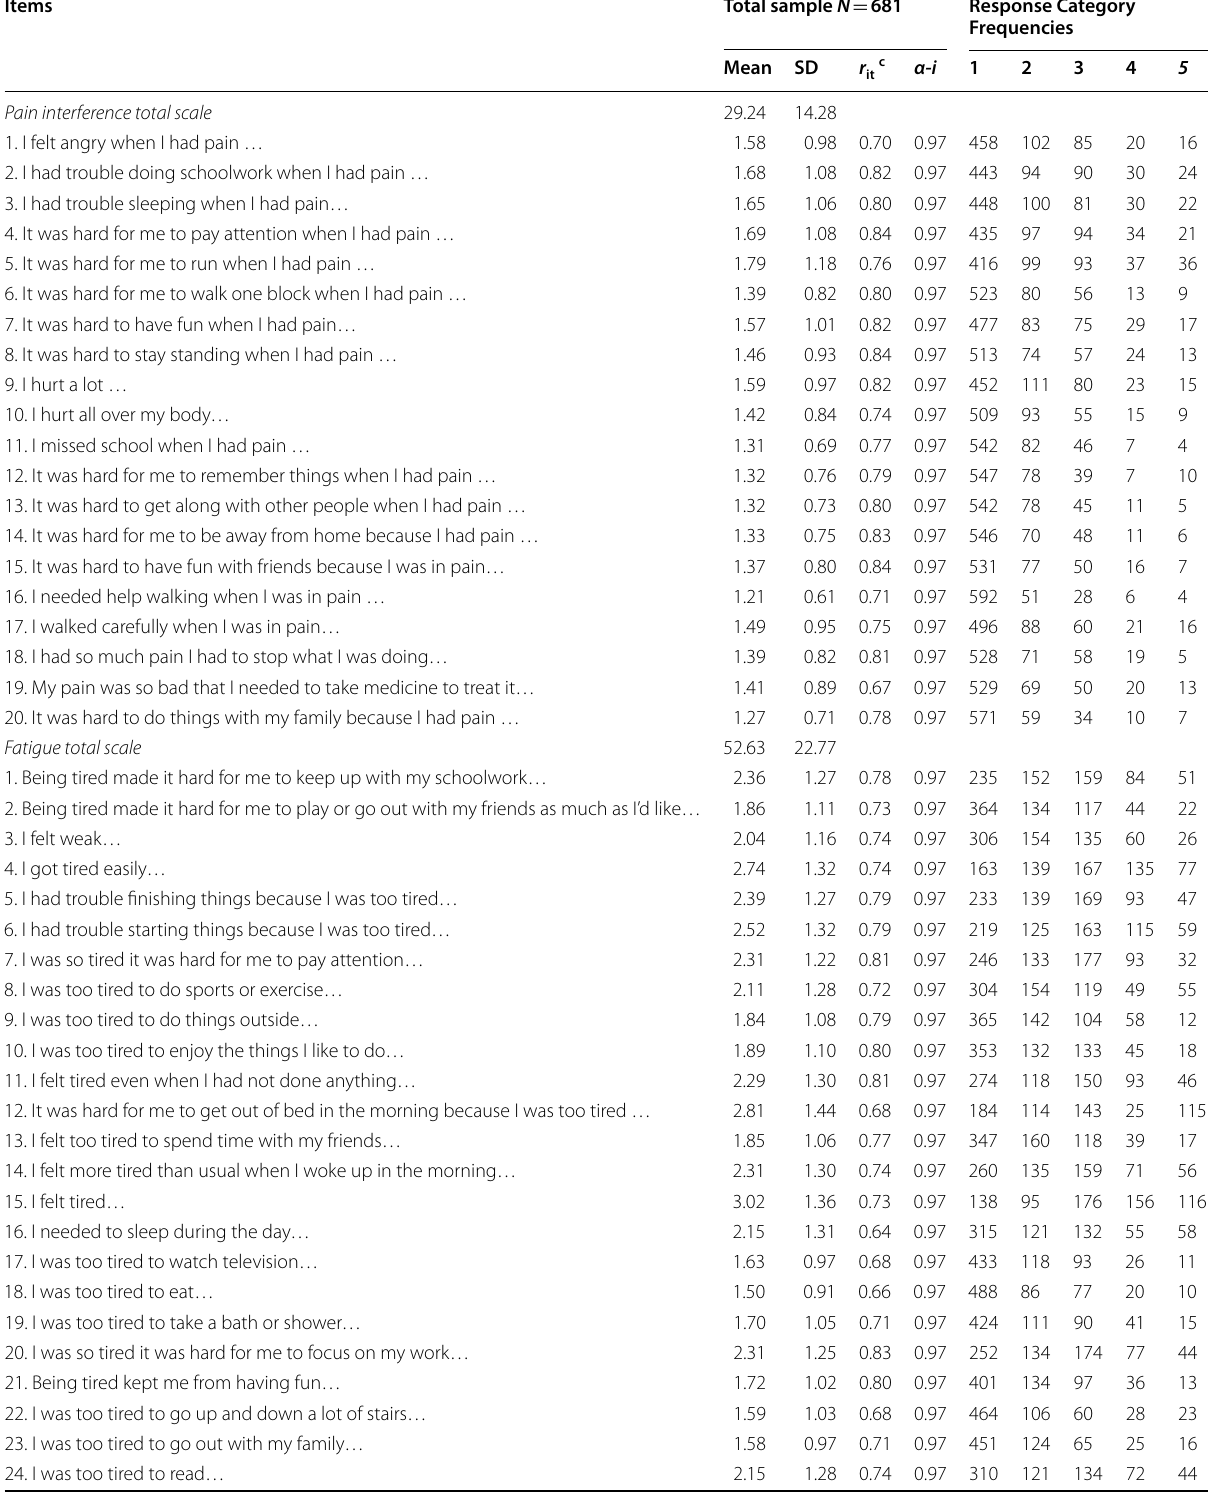
Table 1 Descriptive statistics for the Swedish translated PROMIS Pediatric item banks Pain Interference v.2.0., Pediatric Fatigue v.2.0., and Pediatric Physical Activity